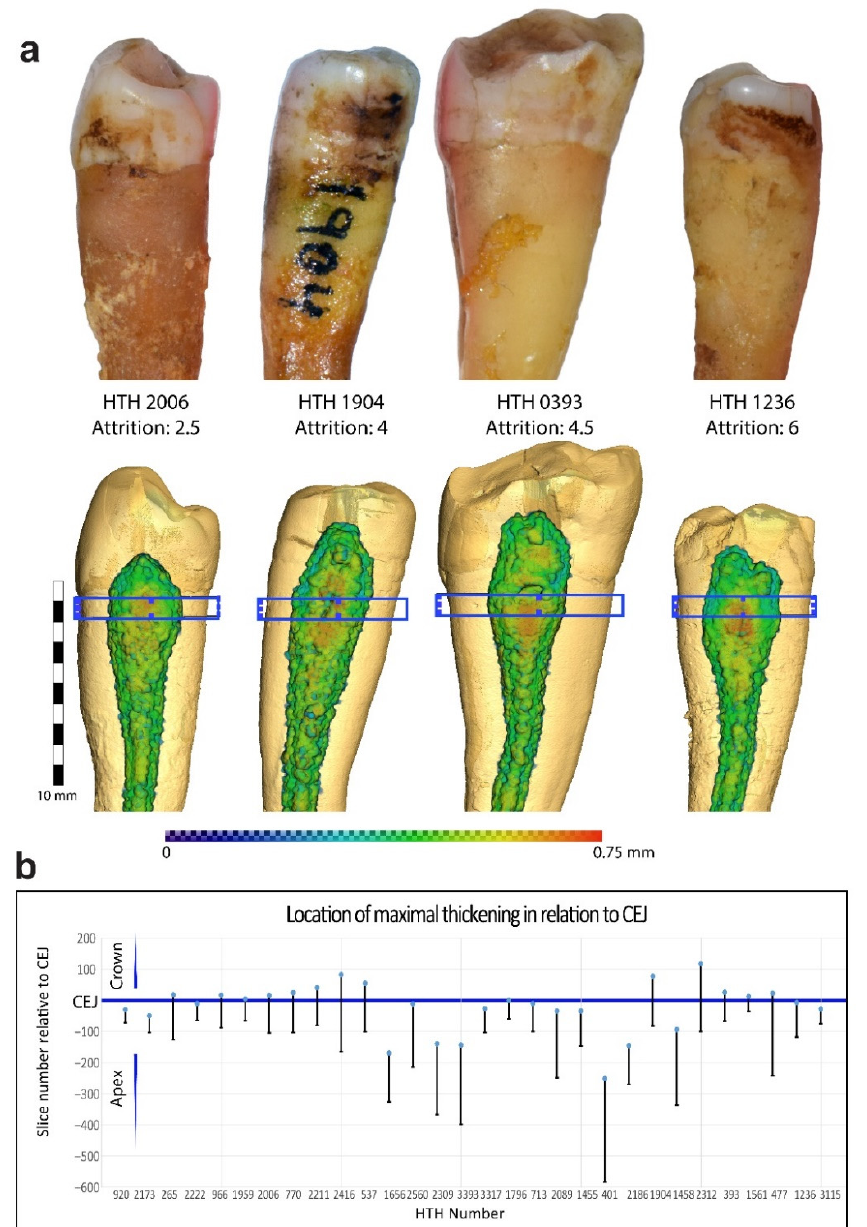
Figure 2. Three-dimensional thickness map. ( a ) Images of four teeth (on top) and isosurface of the teeth with a three-dimensional thickness map overlaid (below). A blue box indicates a 1 mm slice below the CEJ. The bottom legend indicates SD thickness ranging from 0 to 0.75 mm. ( b ) Vertical distribution of maximal SD thickening. The blue line indicates CEJ level, and the bars indicate maximal thickening for each tooth. Slice numbers are relative to CEJ. n = 30.